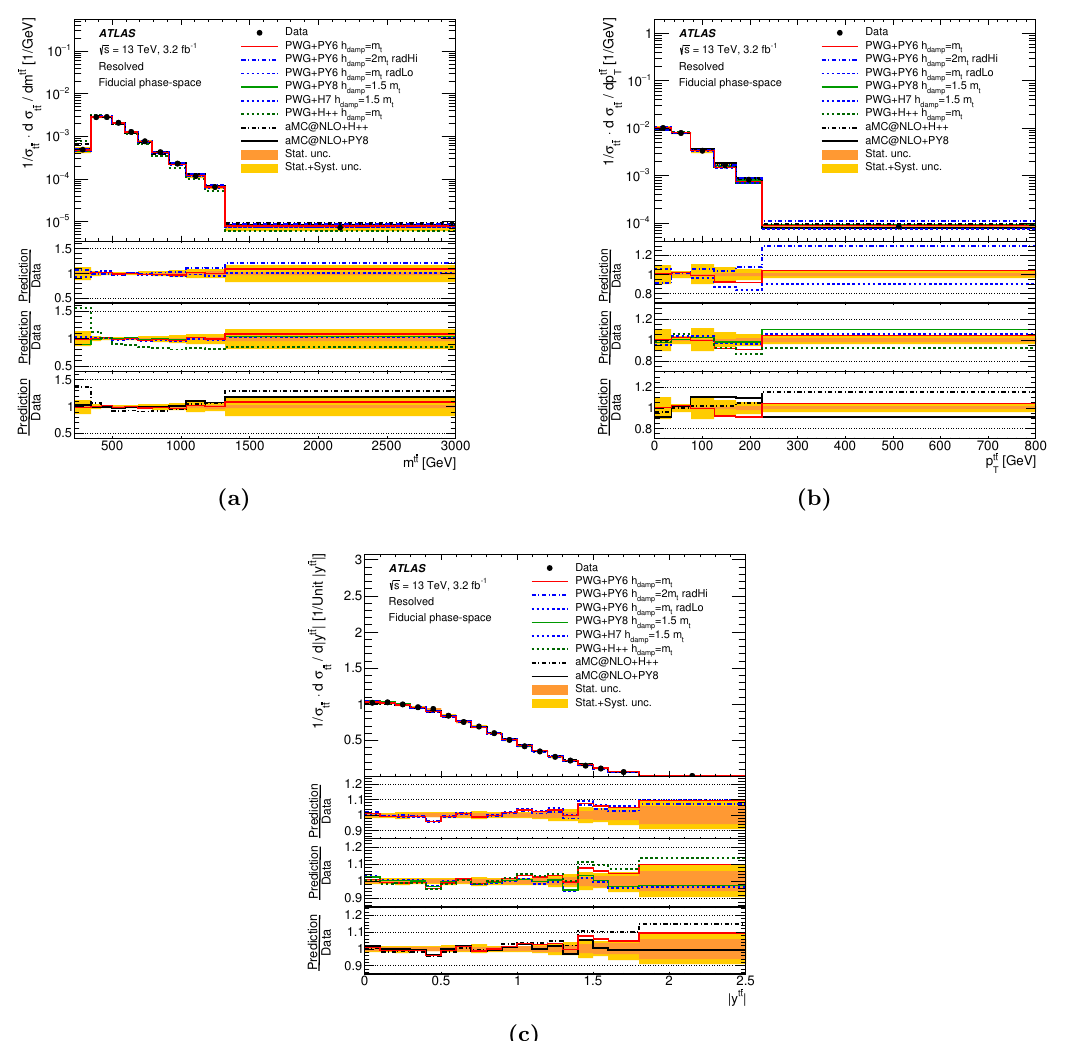
Figure 18. Fiducial phase-space relative di(cid:11)erential cross-sections as a function of the (a) invariant (cid:12) (cid:22) t (cid:12) mass ( m t (cid:22) t ), (b) transverse momentum ( p t (cid:22) t ) and (c) the absolute value of the rapidity ( (cid:12) y t (cid:12) ) of the t (cid:22) t T system in the resolved topology. The yellow bands indicate the total uncertainty of the data in each bin. The Powheg + Pythia6 generator with h damp = m t and the CT10 PDF is used as the nominal prediction to correct for detector e(cid:11)ects. The lower three panels show the ratio of the predictions to the data. The (cid:12)rst panel compares the three Powheg + Pythia6 samples with di(cid:11)erent settings for additional radiation, the second panel compares the nominal Powheg + Pythia6 sample with the other Powheg samples and the third panel compares the nominal Powheg + Pythia6 sample with the MadGraph5 a MC@NLO